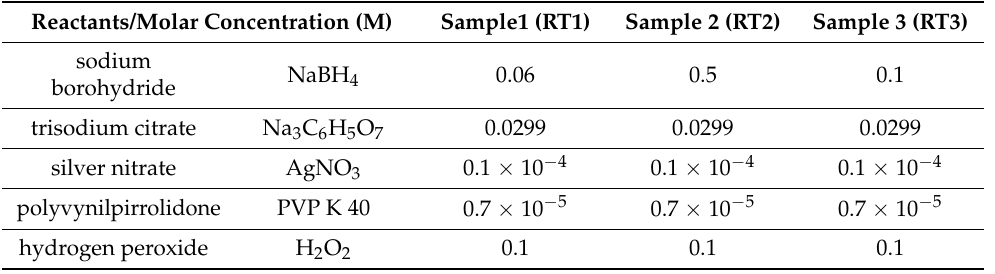
Figure 1. Technological scheme of the chemical routes at the room temperature (RT). Table 1. The order and molar concentration of components added for each sample obtained by the chemical reduction at the room temperature method .